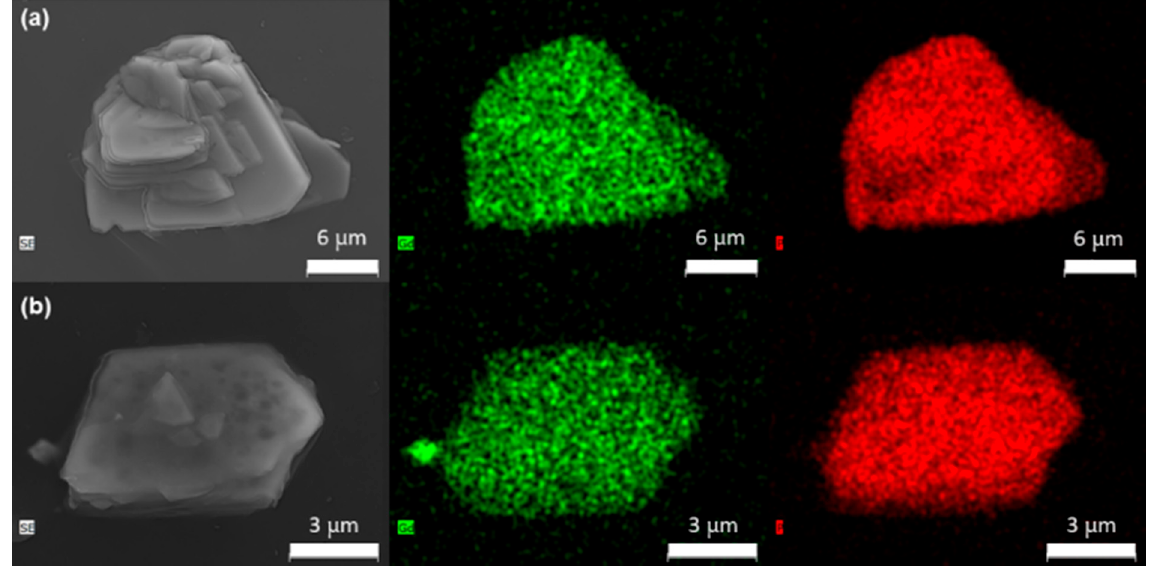
Figure 8. SEM and respective elemental mappings (Gd (green); P (red)) for the fresh ( a ) and used ( b ) catalyst 1 . The powder X-ray diffraction (PXRD) patterns of the fresh and consecutively used solids were similar, suggesting that the crystalline structure of 1 was preserved (Figure 9).